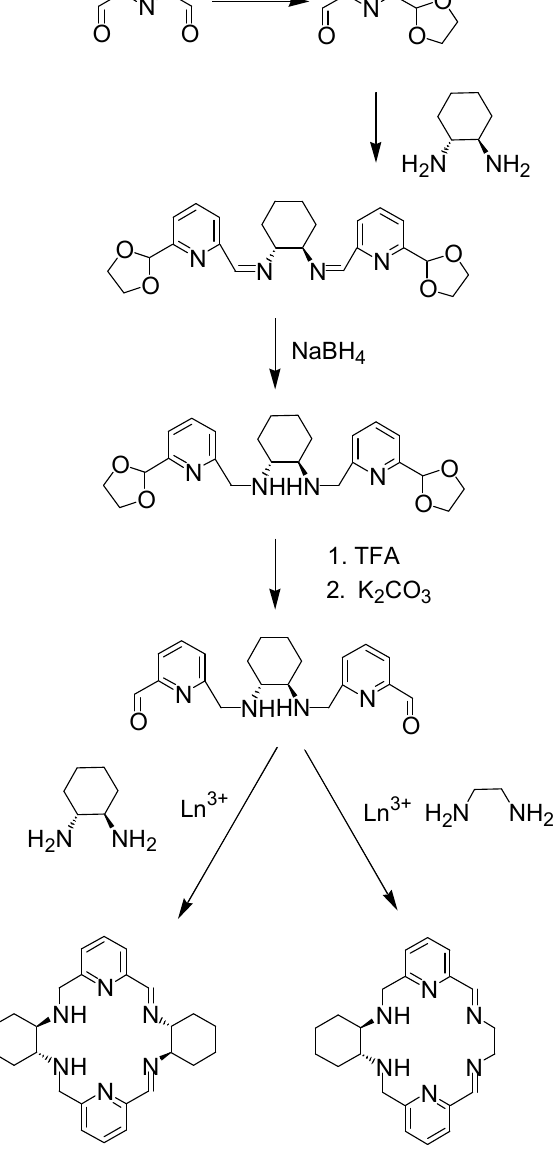
Figure 33. Step-wise synthesis of unsymmetrical imine/amine macrocycles.